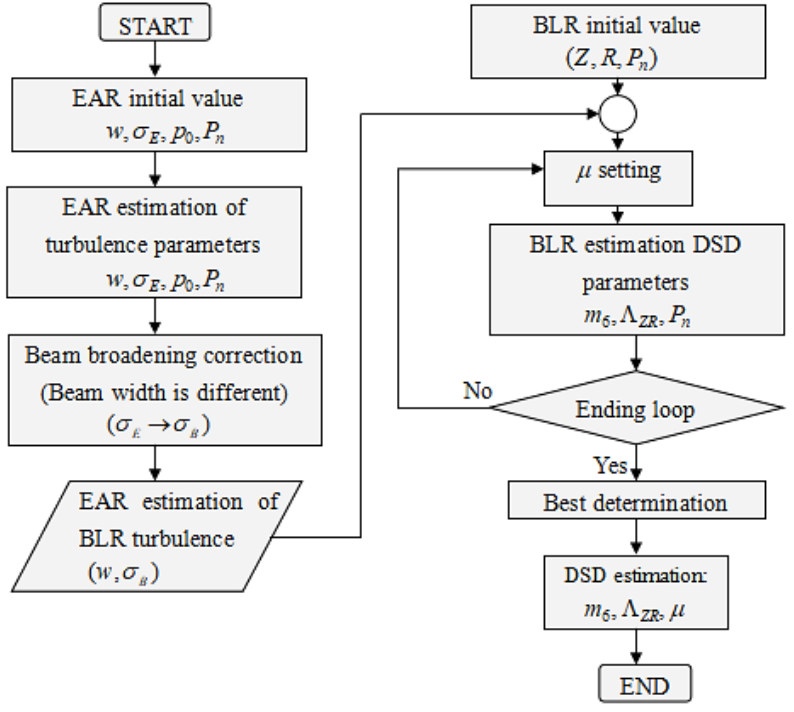
Figure 2. Flow chart of research